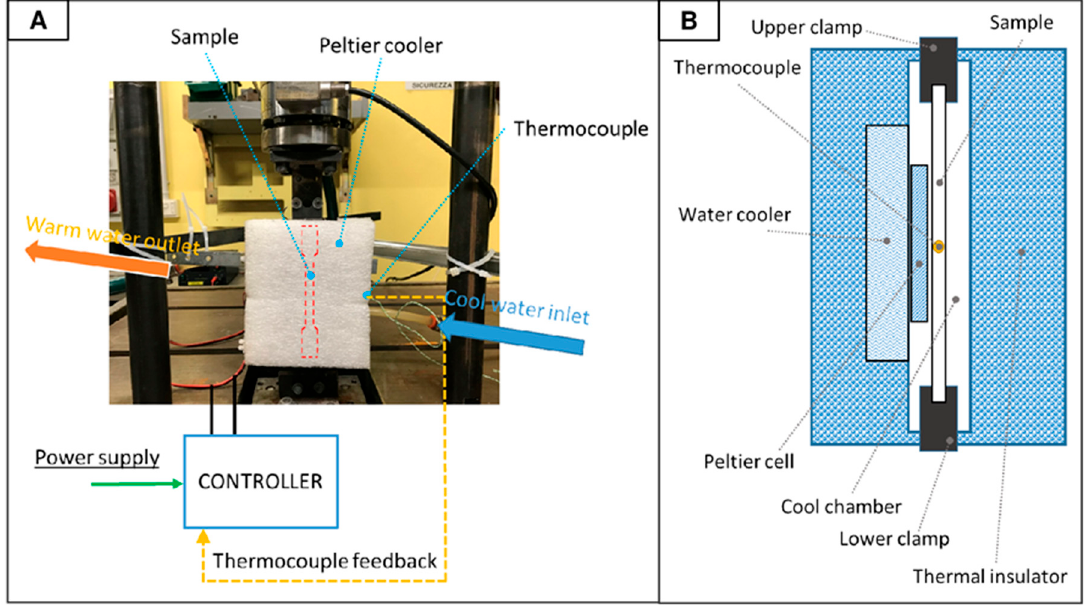
Figure 2. Experimental set-up for low temperature tests: equipment mounted in the fatigue machine ( A ) and schematic detail of the water–Peltier cooler ( B ).